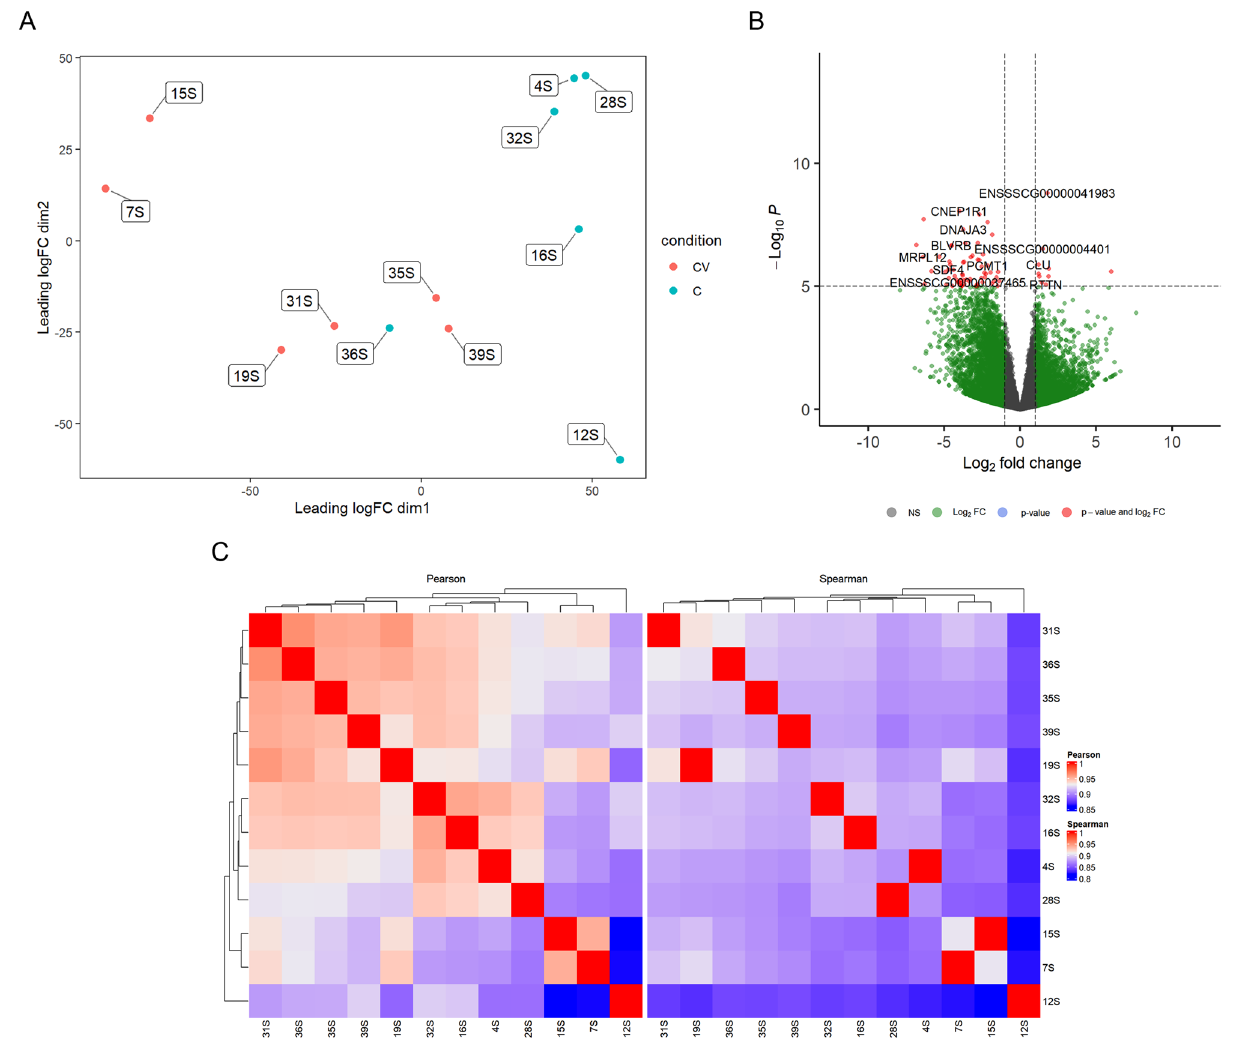
Figure 2. ( A ) Multi-dimensional scaling (MDS) plot showing the relation between Control and CV diet samples. ( B ) Volcano plot showing the relationship between FC and evidence of differential expression (-log FDR) for Control vs CV. ( C ) Clustering of sample to sample correlations—Control vs CV. Hierarchical clustering of treatment condition samples based on Pearson (left) and Spearman correlations